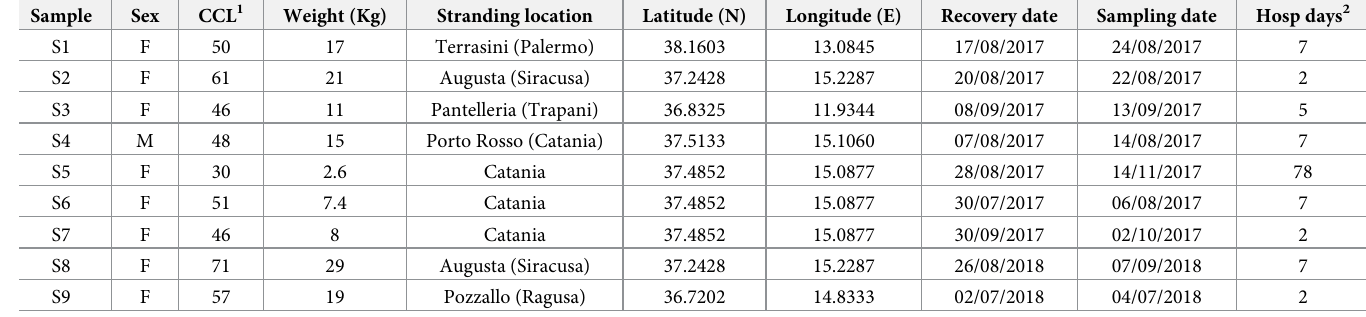
1 indicates the Curved Carapace Length. 2 indicates days of hospitalization before fecal sample